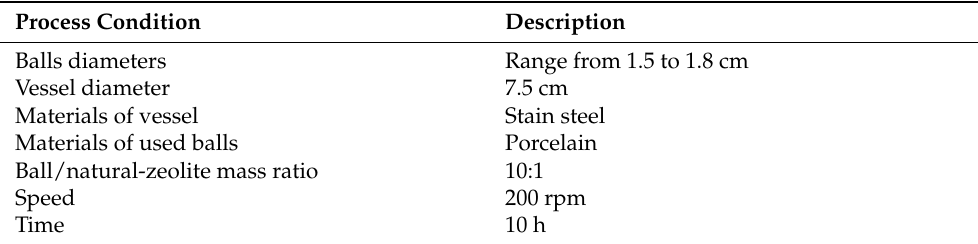
Table 2. Conditions of the ball milling process for the preparation of Zeolite. Process